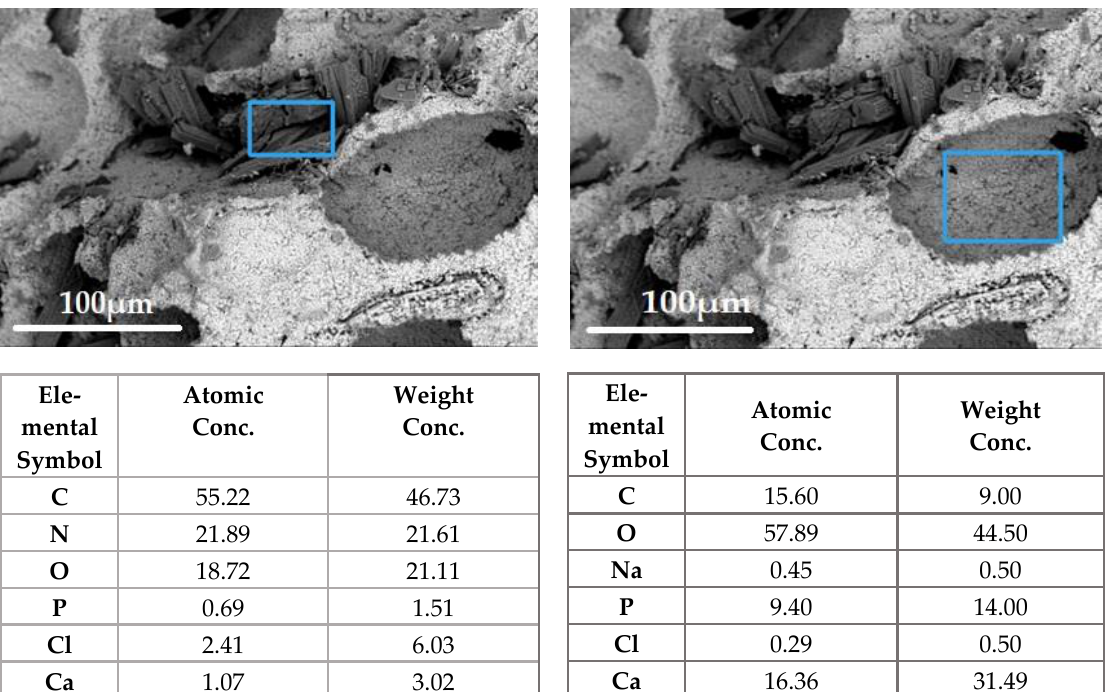
Figure 10. Microstructure of ceramics containing vancomycin, and results of EDX of the area bounded by a blue border.